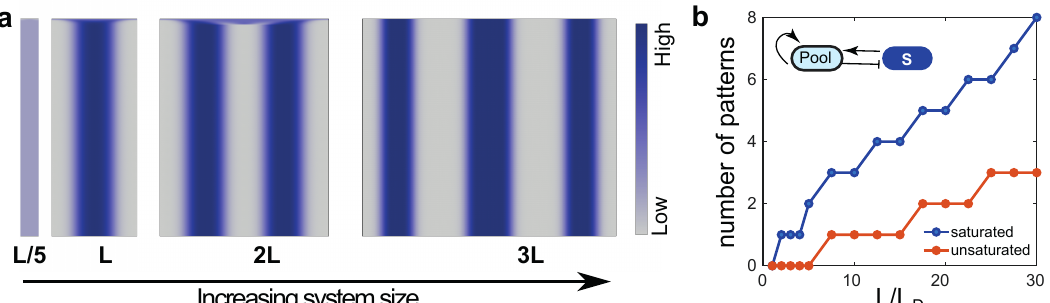
Figure 2. Sequential pattern formation in growing domains. ( a ) Kymographs of S ( x , t ) for increasing system size. Figures show spontaneous pattern formation via symmetry breaking of the homogeneous state above a critical system size L ∗ . As we simulate larger systems (Equations (1) and (2)), multiple patterns emerge in a size-dependent manner. Simulations were done as described in Figure